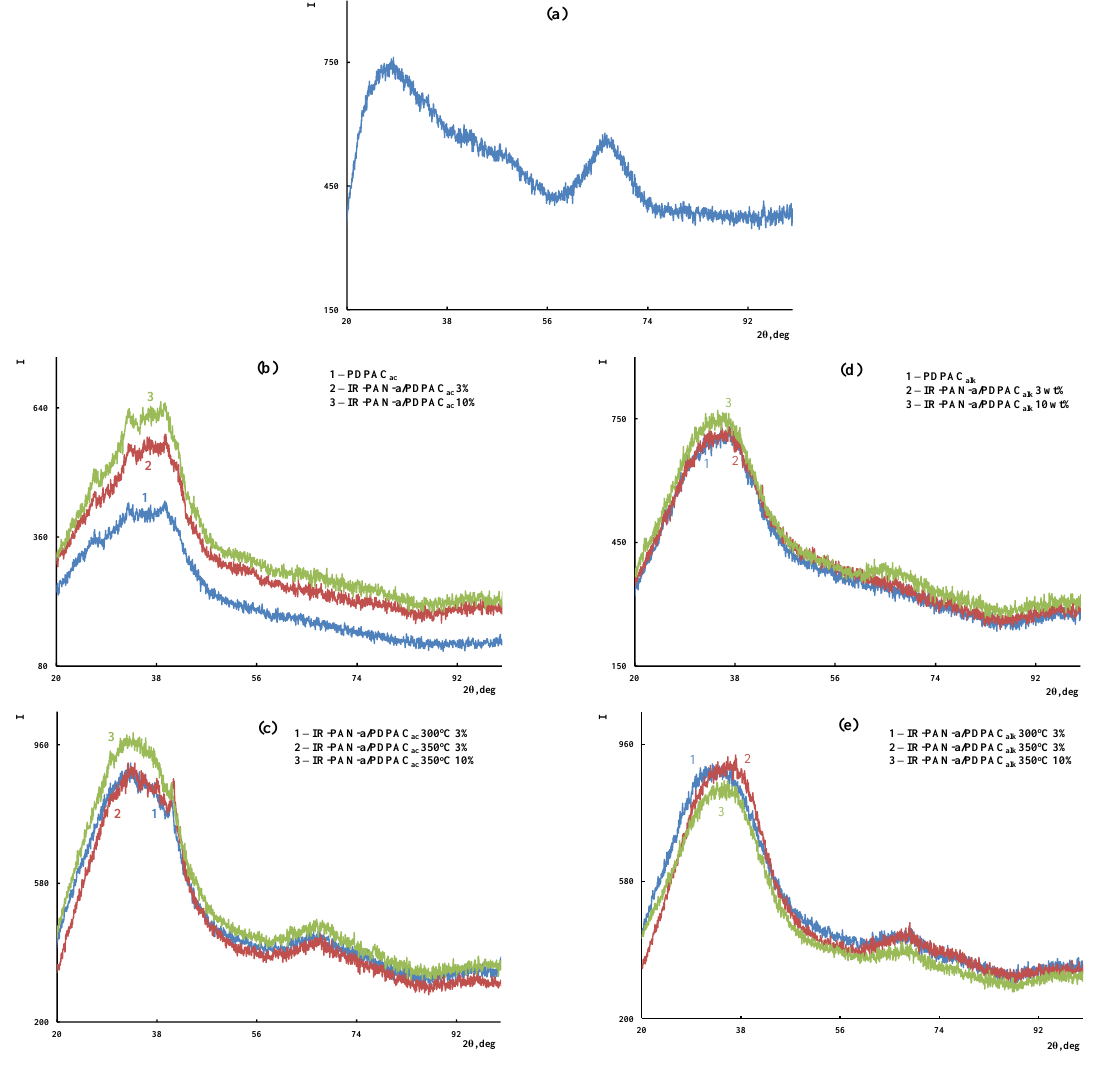
Figure 3. XRD of IR-PAN-a ( a ), PDPAC and IR-PAN-a/PDPAC ( b , d ), and IR-PAN-a/PDPAC IR ( c , e